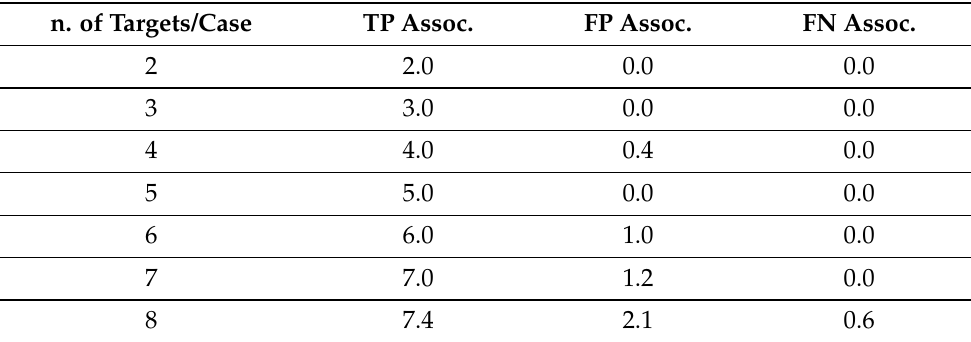
Table 2. Association results for the new proposed method. Average numbers of true-positive (TP), false-positive (FP), and false-negative (FN) associations from 100 Monte Carlo simulations are shown. n. of